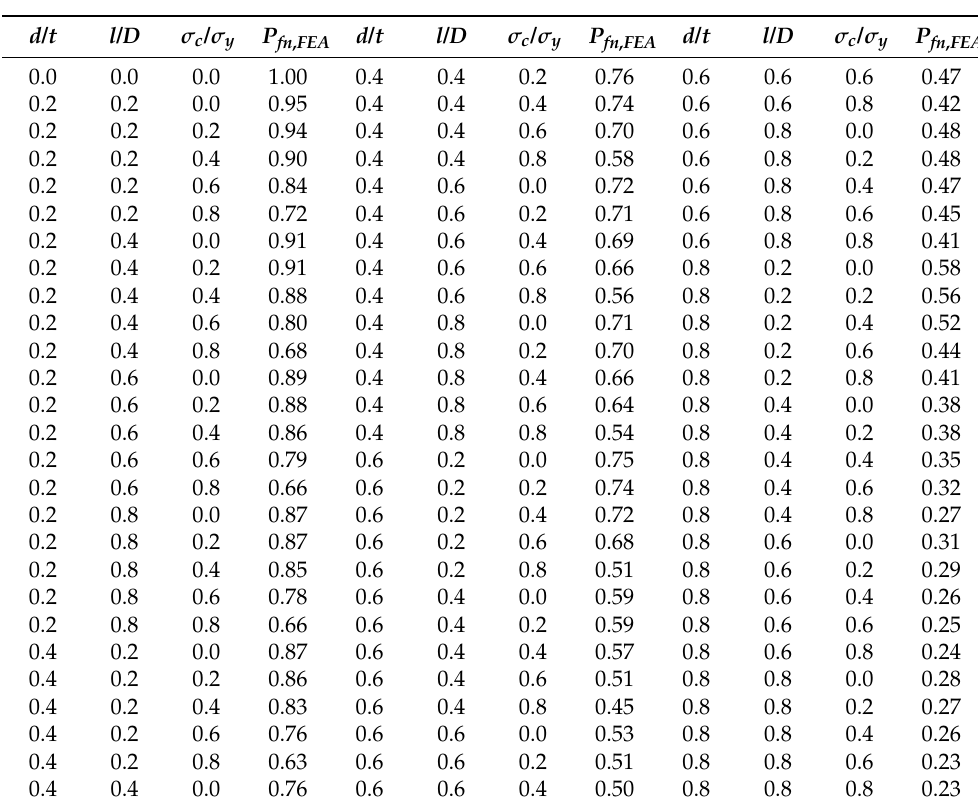
Table 5. ANN training